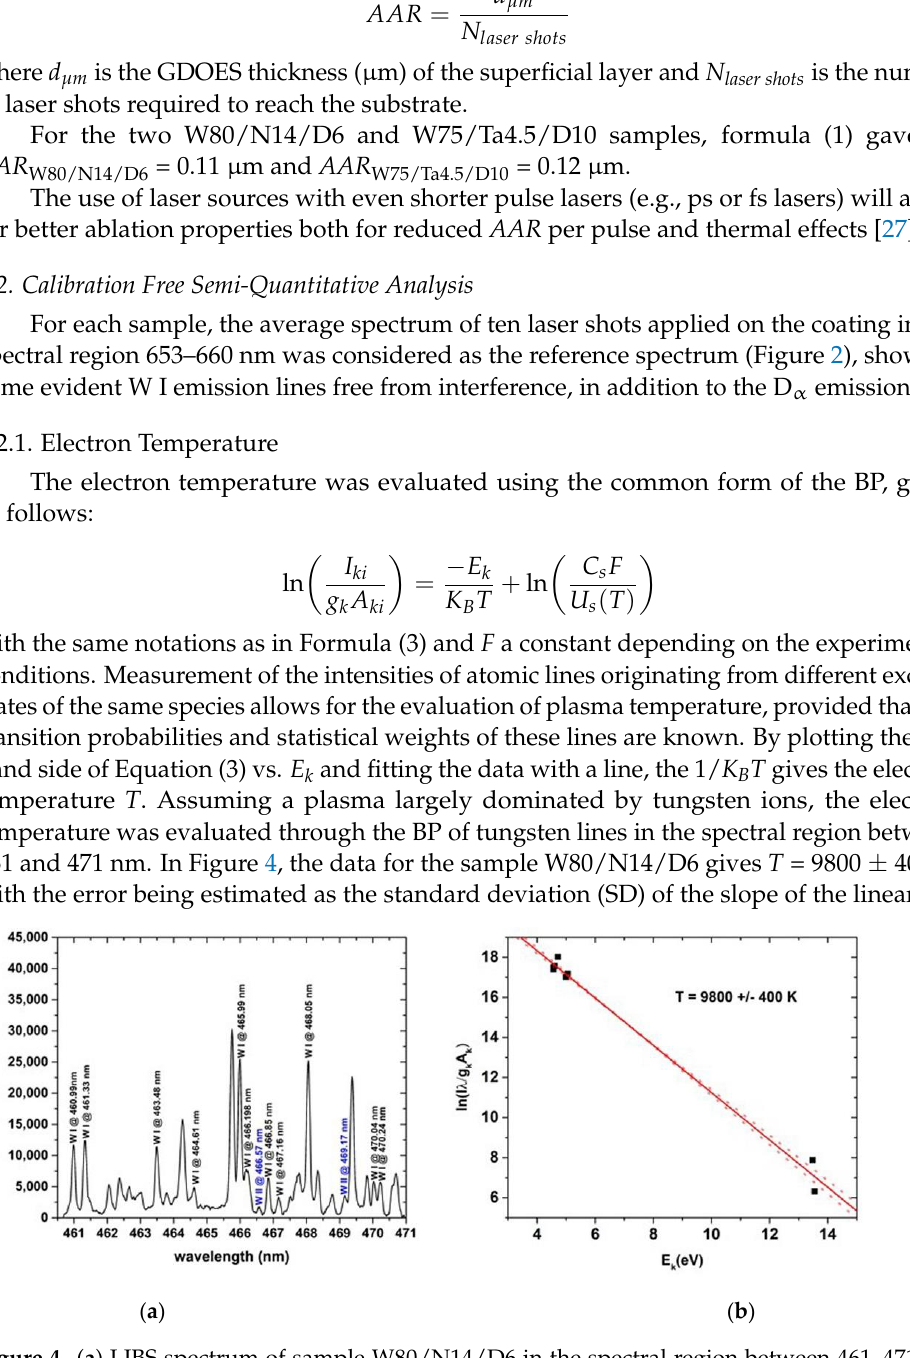
Figure 4. ( a ) LIBS spectrum of sample W80/N14/D6 in the spectral region between 461 – 471 nm. Labeled in black atomic emission lines and in blue ionic emission lines. ( b ) BP of the W emission lines between 461 and 471 nm; the red line represents the best linear fit, while the red-dotted lines represent linear fits with maximum and minimum slope within the SD.